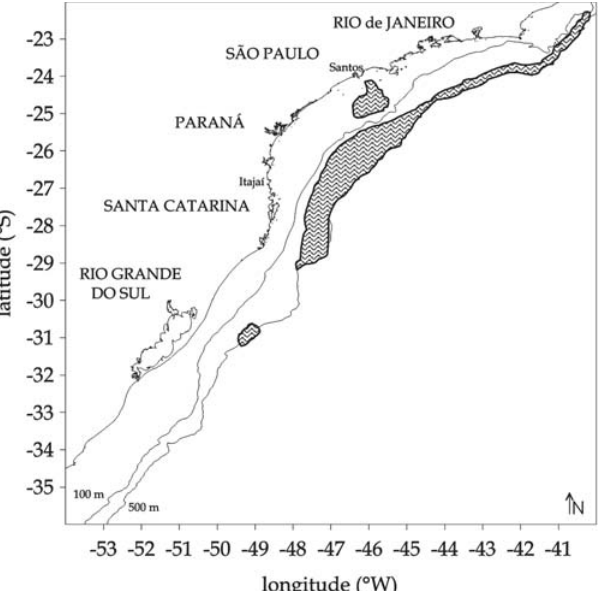
Fig. 1. Merluccius hubbsi : area of collection of samples ob- tained during surveys and the operations of the commercial fish- ing fleet of Santos and Guarujá in the period from 1996 to